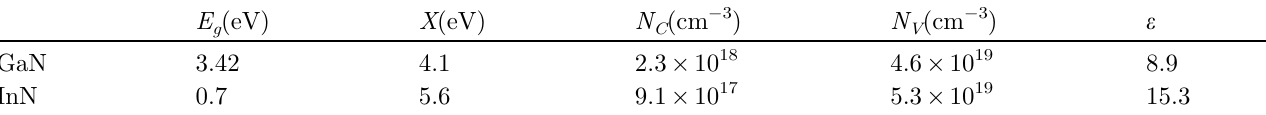
the InGaN bandgap for a given indium composition x . g